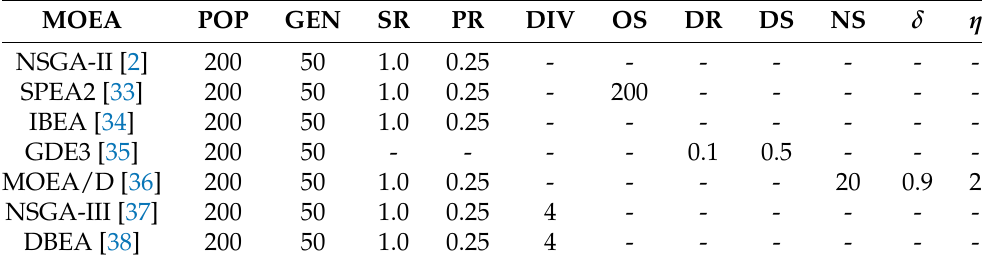
Table 1. Parameter setting in the experiment. Detail description is summarized in Table